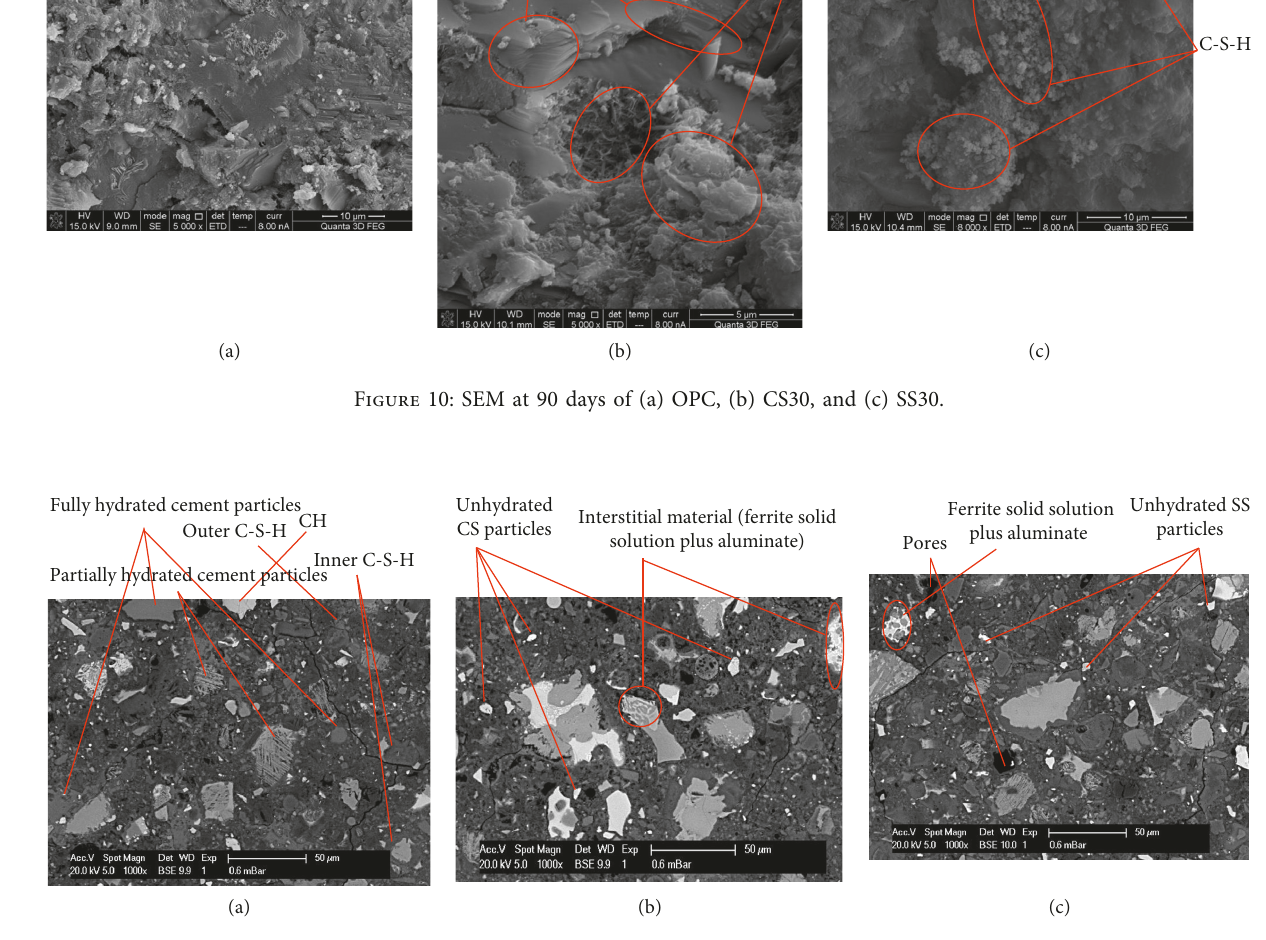
Figure 11: BSE image for (a) OPC, (b) CS30, and (c) SS30 hydrated for